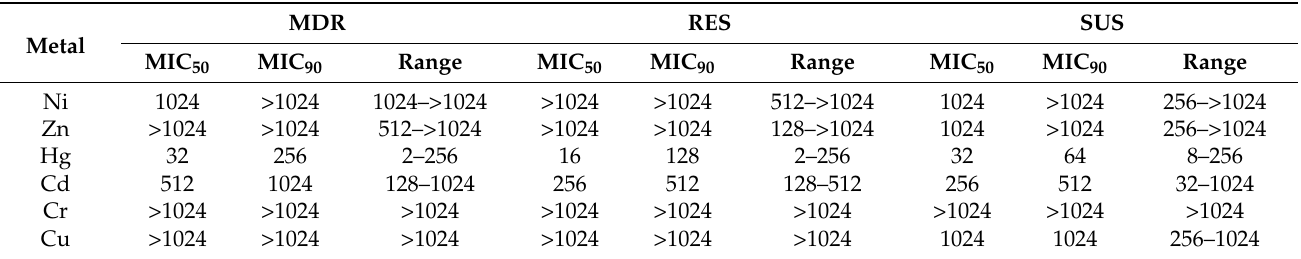
Table 4. Toxic metal tolerance patterns ( µ g/mL) of mesophilic aerobe and facultatively anaer- obic Gram-negative rods presumptively characterized as enterobacteria isolated from meat and fish samples.